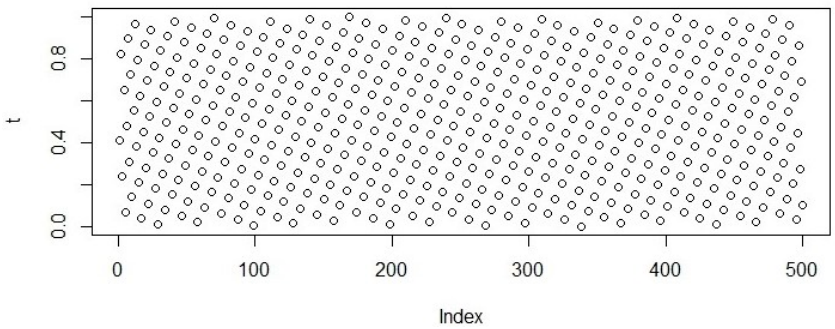
Figure 6. Sample data generated using Torus distribution . Algorithm 3 shows the proposed distribution-based PSO initialization: Algorithm 3 Proposed Pseudocode of PSO Using Novel Method of Initialization